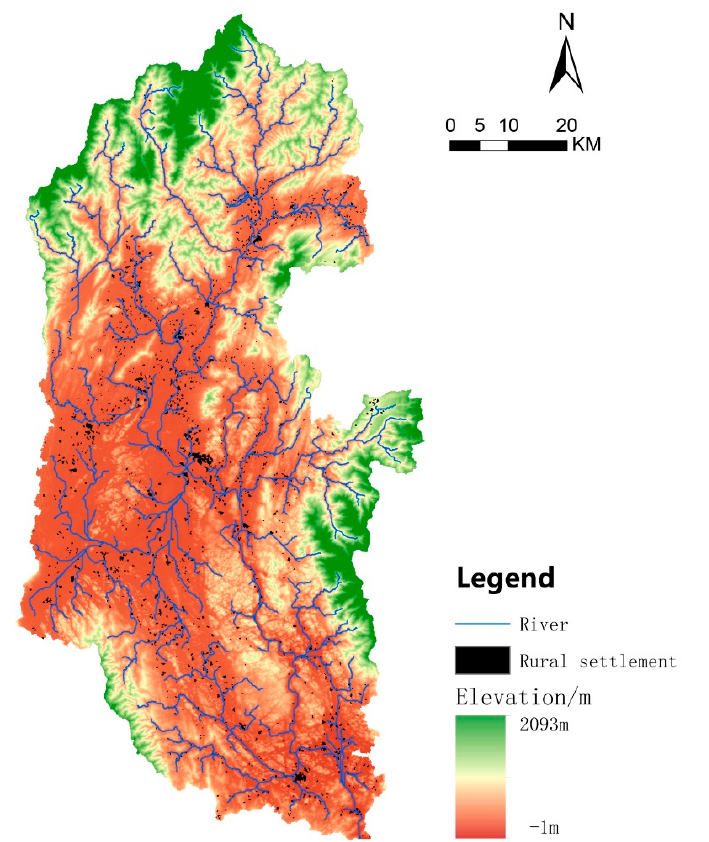
Figure 5. Elevation map of rural settlement distribution in the Lijiang River Basin. Black spots indi- cate rural settlements.